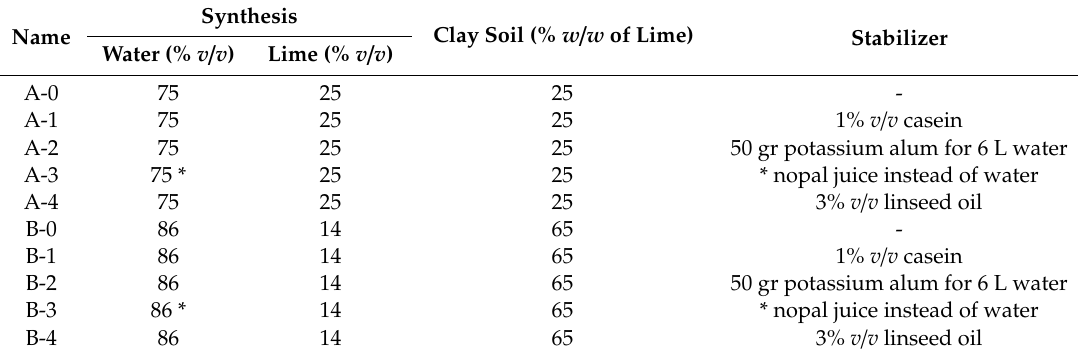
Table 3. Synthesis of limecolours.